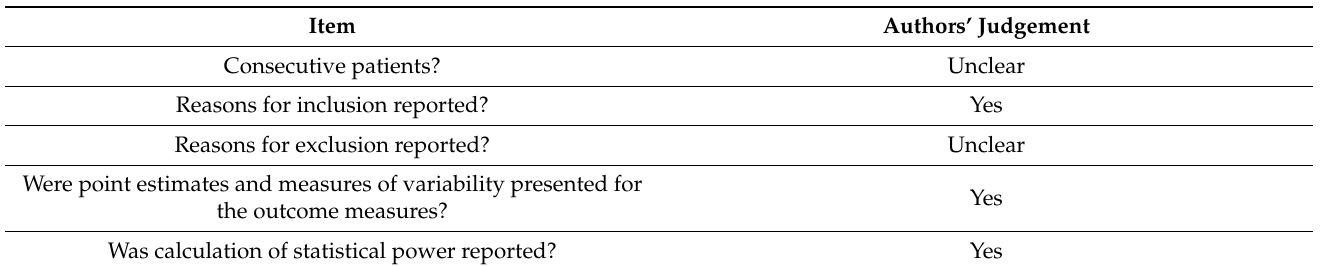
Table A20. Quality assessment.